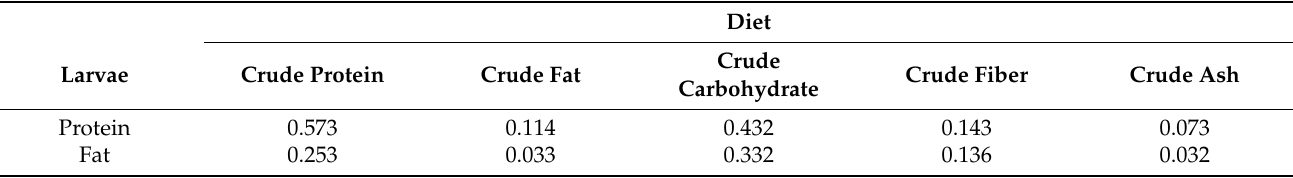
Table 7. Regression coefficients (R 2 ) showing correlation of the diet composition with protein and fat contents of Tenebrio molitor larvae after linear regression